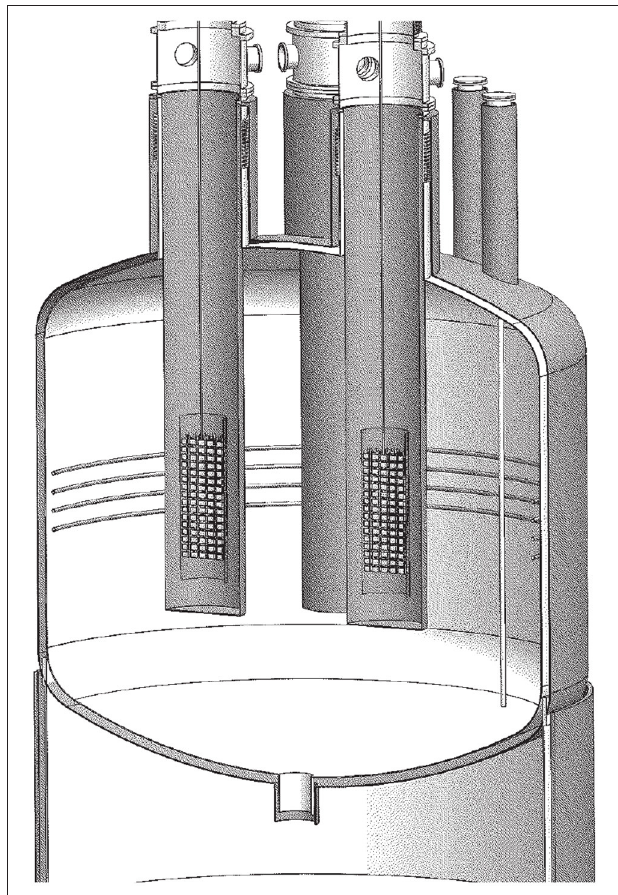
FIGURE 10 | The concept for LEGEND-1000 showing a number of the deployments Ge detectors. This cut-away view shows three of five 200-kg groupings of Ge. Figure courtesy the LEGEND